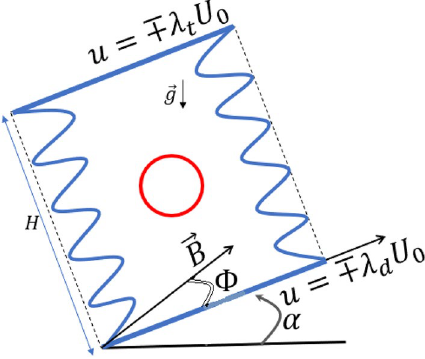
Fig. 1 Schematic diagram of the